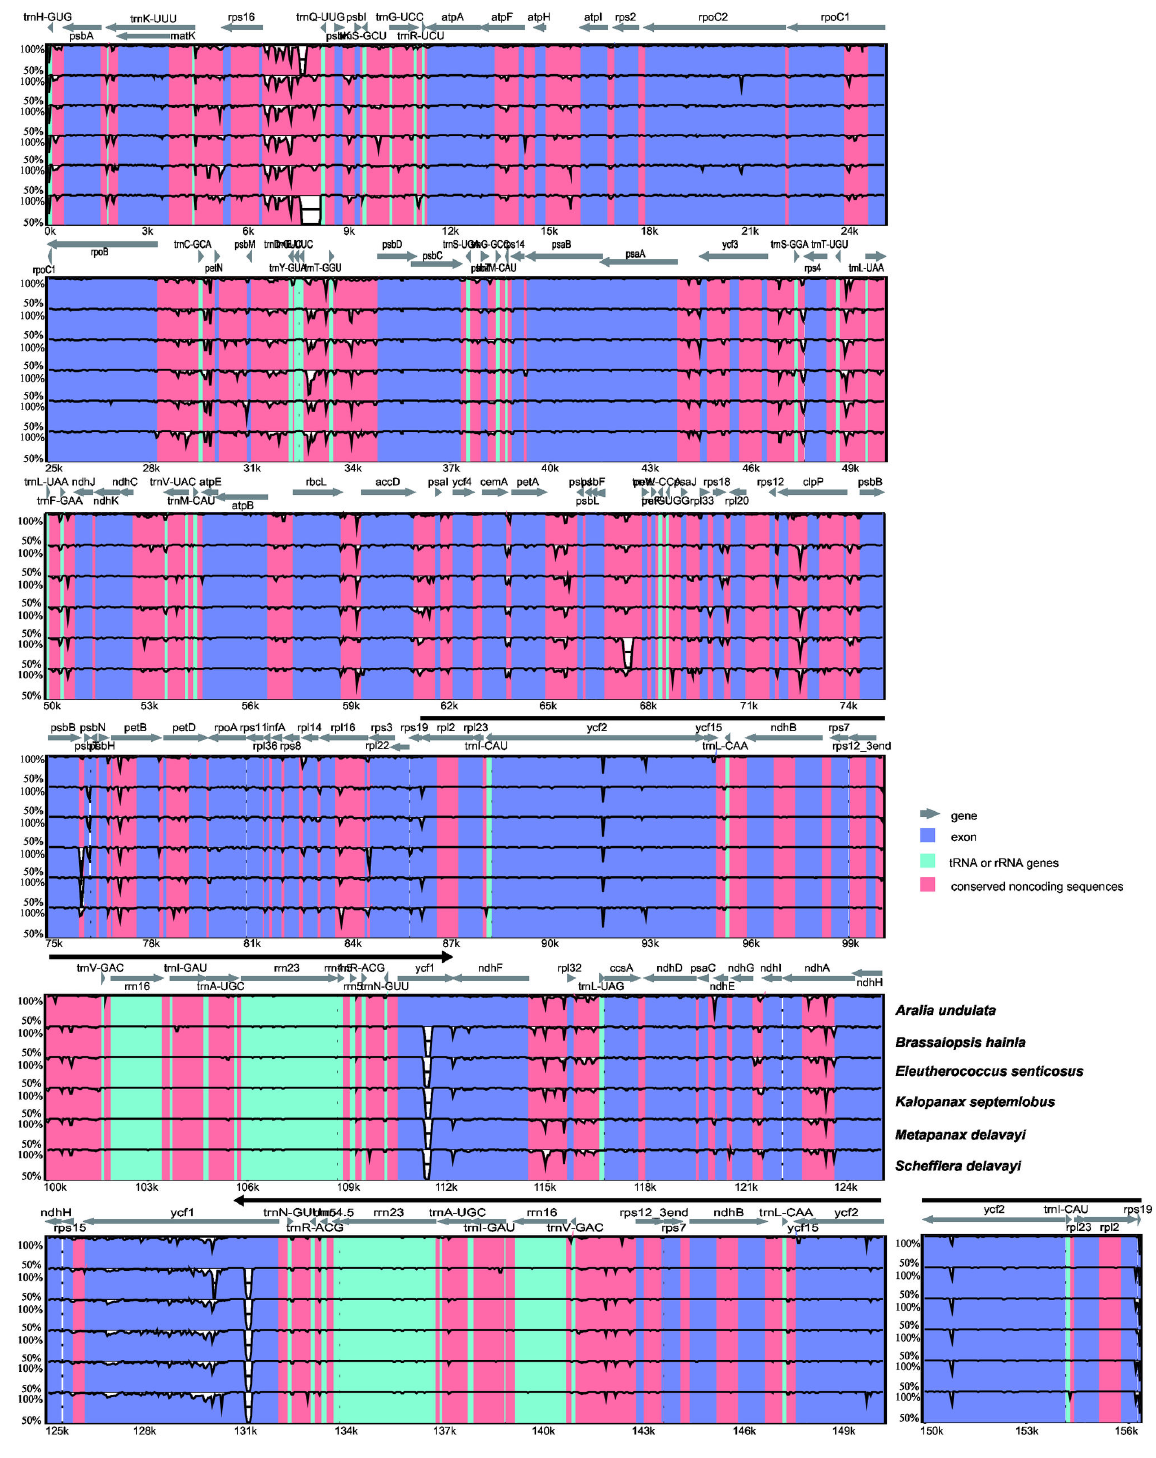
Figure 2. A percent identity plot showing the overall sequence similarity of the seven Araliaceae chloroplast genomes. Pair-wise comparison of chloroplast genomes within the Araliaceae using the mVISTA program with Panax ginseng as reference. The Y scale represents % identity ranging from 50–100%. Thick black lines show the inverted repeats (IRs) regions in the chloroplast genome. Genome regions are color-coded as protein coding, tRNA or rRNA genes, and conserved noncoding sequences. doi: 10.1371/journal.pone.0078568.g002 PLOS ONE |